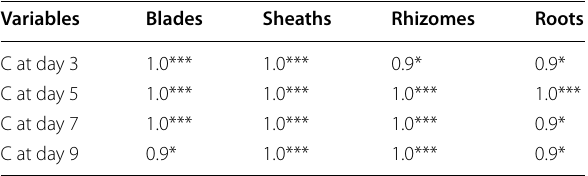
Table 1 Spearman’s rank correlation coefficient values between exposure concentration and experimental tissue cadmium concentration (C) at each incubation